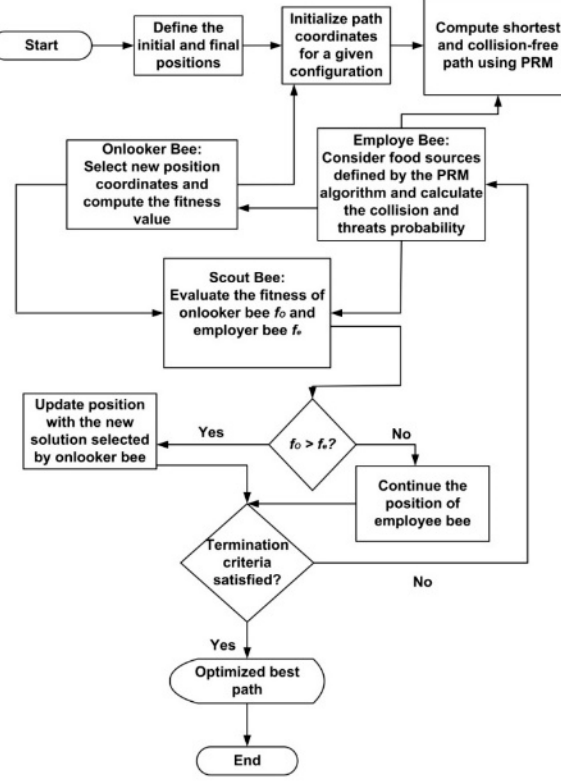
Figure 3. Operation flow of the proposed HPP algorithm.